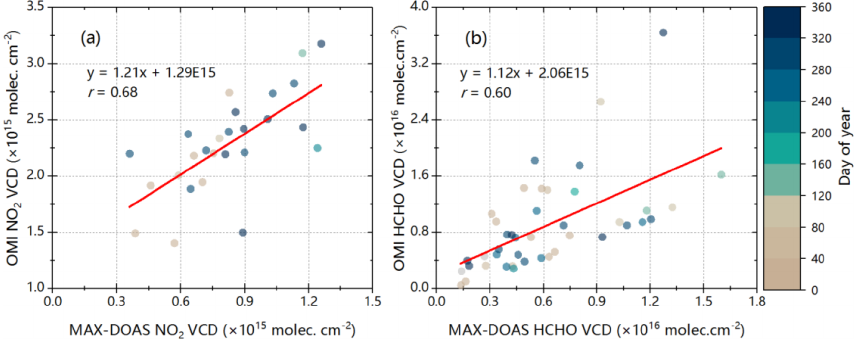
Figure 12. Linear regression plots (a) of the tropospheric NO 2 VCDs measured by OMI and MAX-DOAS and (b) of the tropospheric HCHO VCDs measured by OMI and